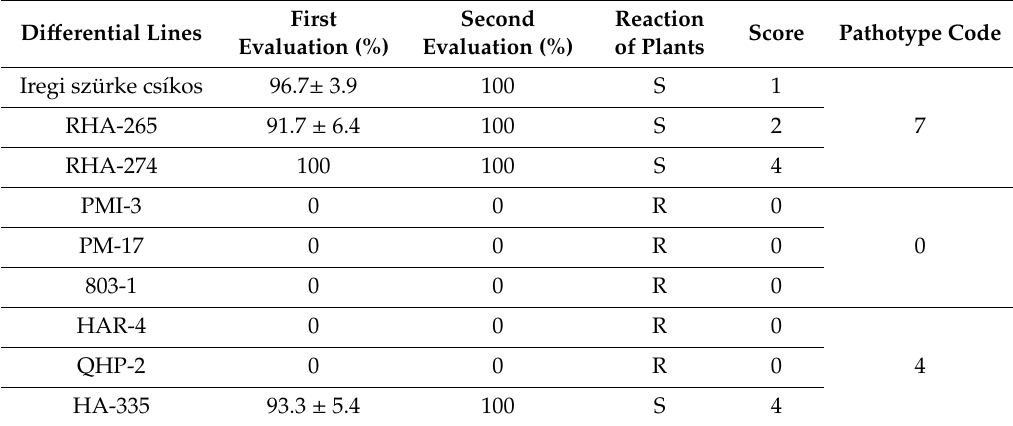
Table 2. Pathotype characterization of P. halstedii isolate used in the test. (S = Susceptible, R = Resistant). Di ff erential Lines